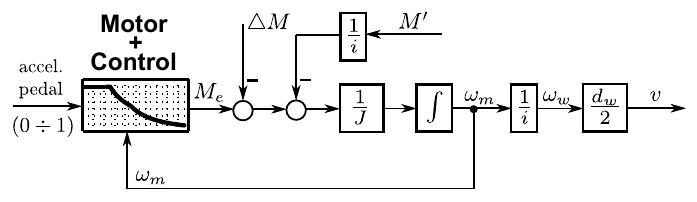
Figure 6. Powertrain model ver.